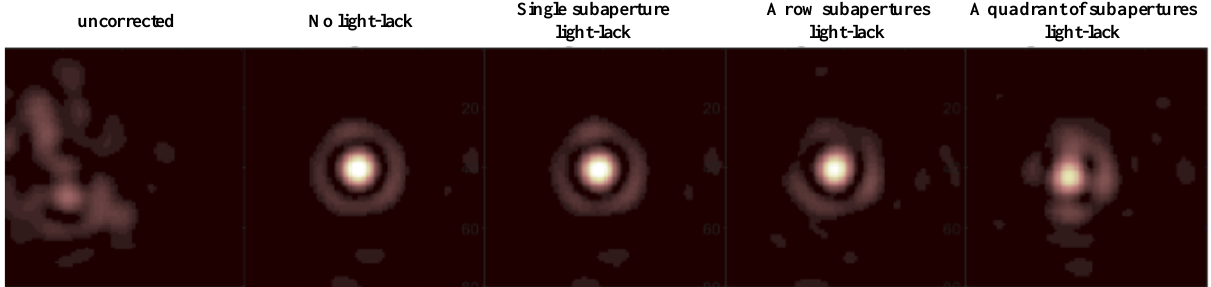
the images without corrected.